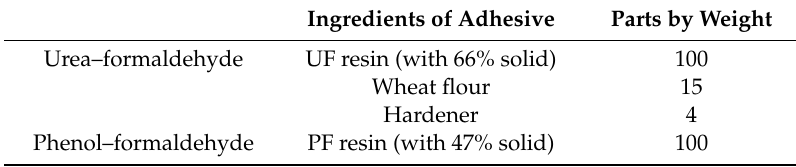
Table 1. Formulations of adhesive mixtures used for the manufacturing of plywood panels. Ingredients of